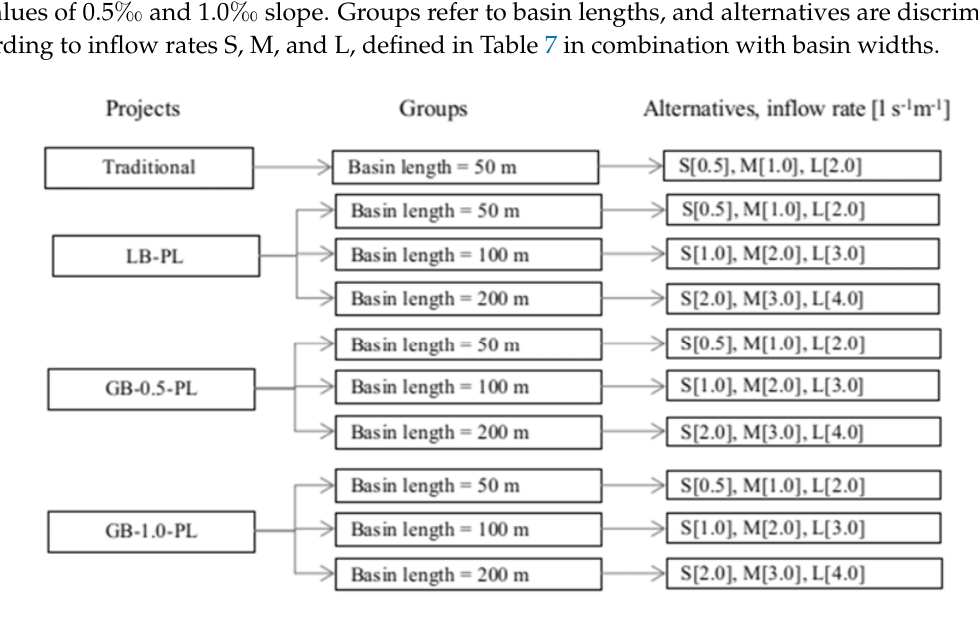
Figure 4. Structure of setting alternatives: projects (traditional, level basin LB and graded basins GB with slopes of 0.5‰ and 1.0‰), grouped for field lengths of 50, 100, and 200 m, and alternatives having different inflow rates and field widths.